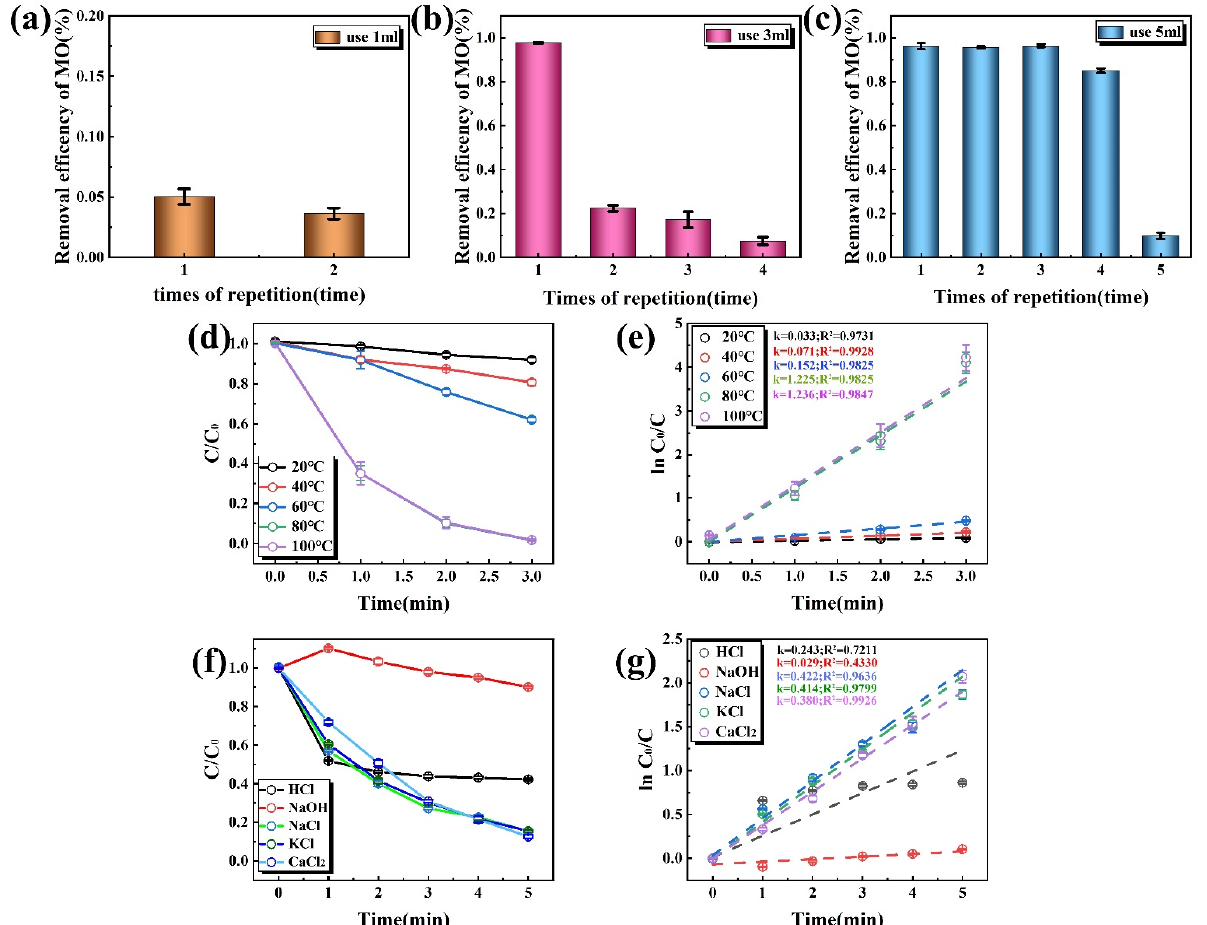
Figure 8. The influence of reuse on removal rates at different catalyst volumes: ( a ) 1 mL, ( b ) 3 mL, and ( c ) 5 mL. ( d ) The effect of different alloy extraction temperatures on the concentration curves for the degradation of MO and ( e ) ln C/C 0. ( f ) The relationship between C/C 0 and time for the degradation of MO with K + , Ca 2+ , Na + , HCl, and NaOH, and ( g ) corresponding linear fitting curves of ln (C 0 /C) versus time.